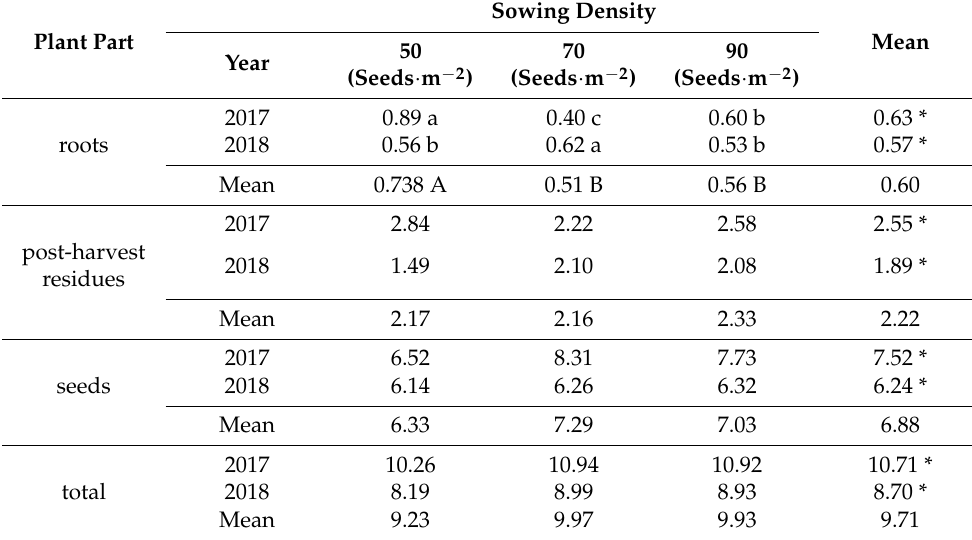
For explanations seed Table